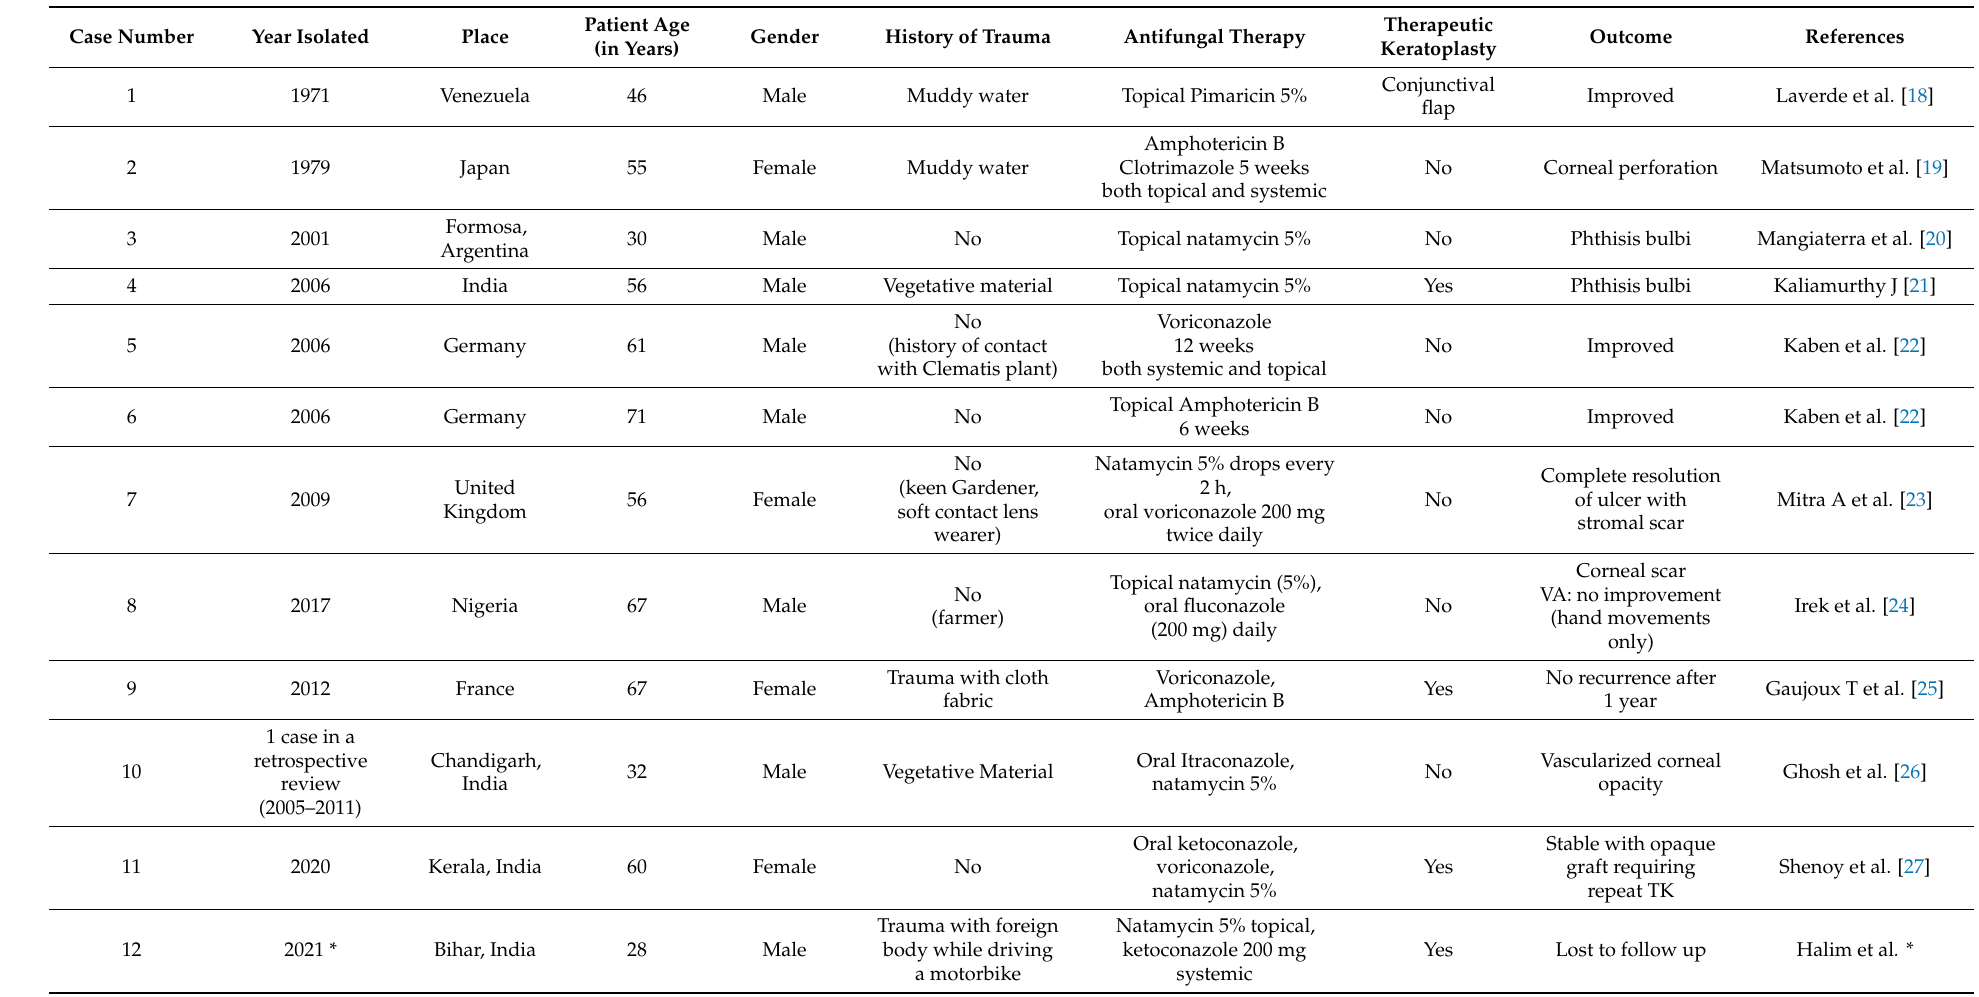
Table 1. Global review of cases of Keratitis due to Fusarium lichenicola